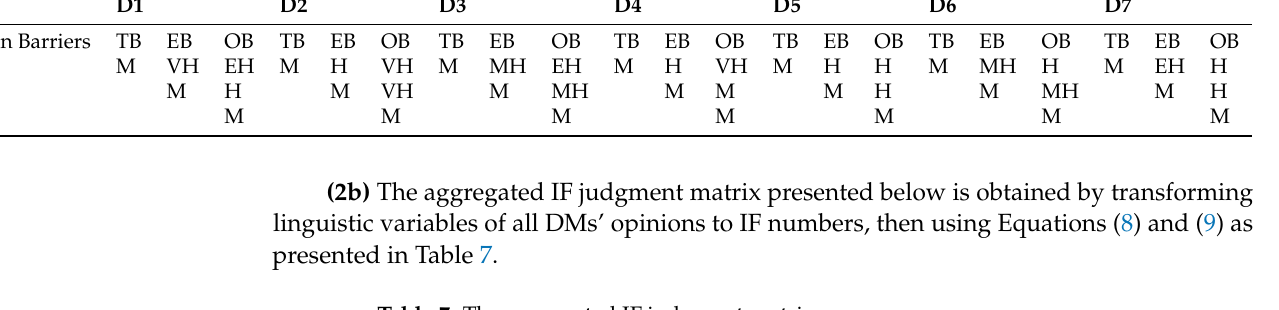
Table 7. The aggregated IF judgment matrix.